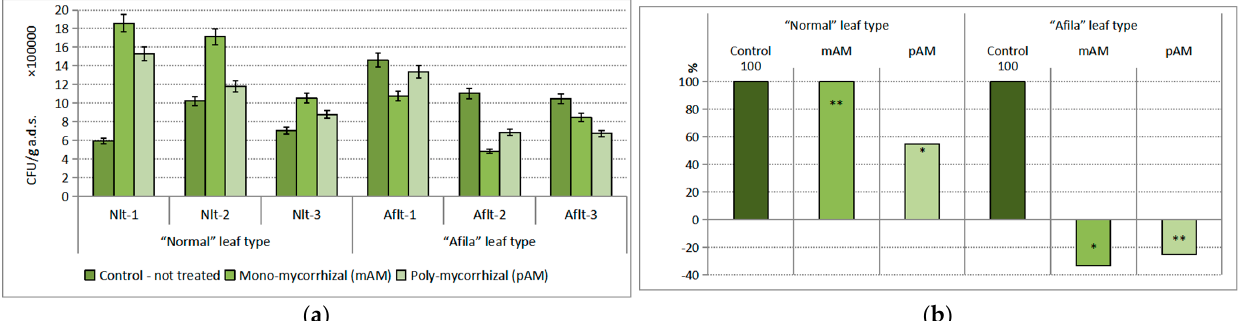
Figure 7. Average population density of the symbiotic nitrogen-fixing bacteria Rhizobium (CFU ∙ g − 1 absolutely dry soil) in the rhizosphere communities formed after introduction of AM fungi: (mAM) mono-mycorrhizal and (pAM) poly-mycorrhizal inoculants. ( a ) Average values for the particular varieties of garden pea with “normal” leaf type (Nlt-1—cvr. Marsi, Nlt-2—cvr. Plovdiv and Nlt-3—cvr. 22/16-n) and “afila” leaf type (Aflt-1—cvr. 22/16-af, Aflt-2—cvr. Kazino and Aflt-3—cvr. Echo). Error bars indicate standard error of the mean (SE). ( b ) Relative values of the differences in the population levels of the symbiotic nitrogen-fixing bacteria Rhizobium (%) compared to the untreated controls, including means for both “normal” leaf type and “afila” leaf type genotypes. The significance of the differences between means of controls and treatments were calculated with the two-tailed Student’s t -test (at df—10; ** p < 0.05 and * p < 0.10).